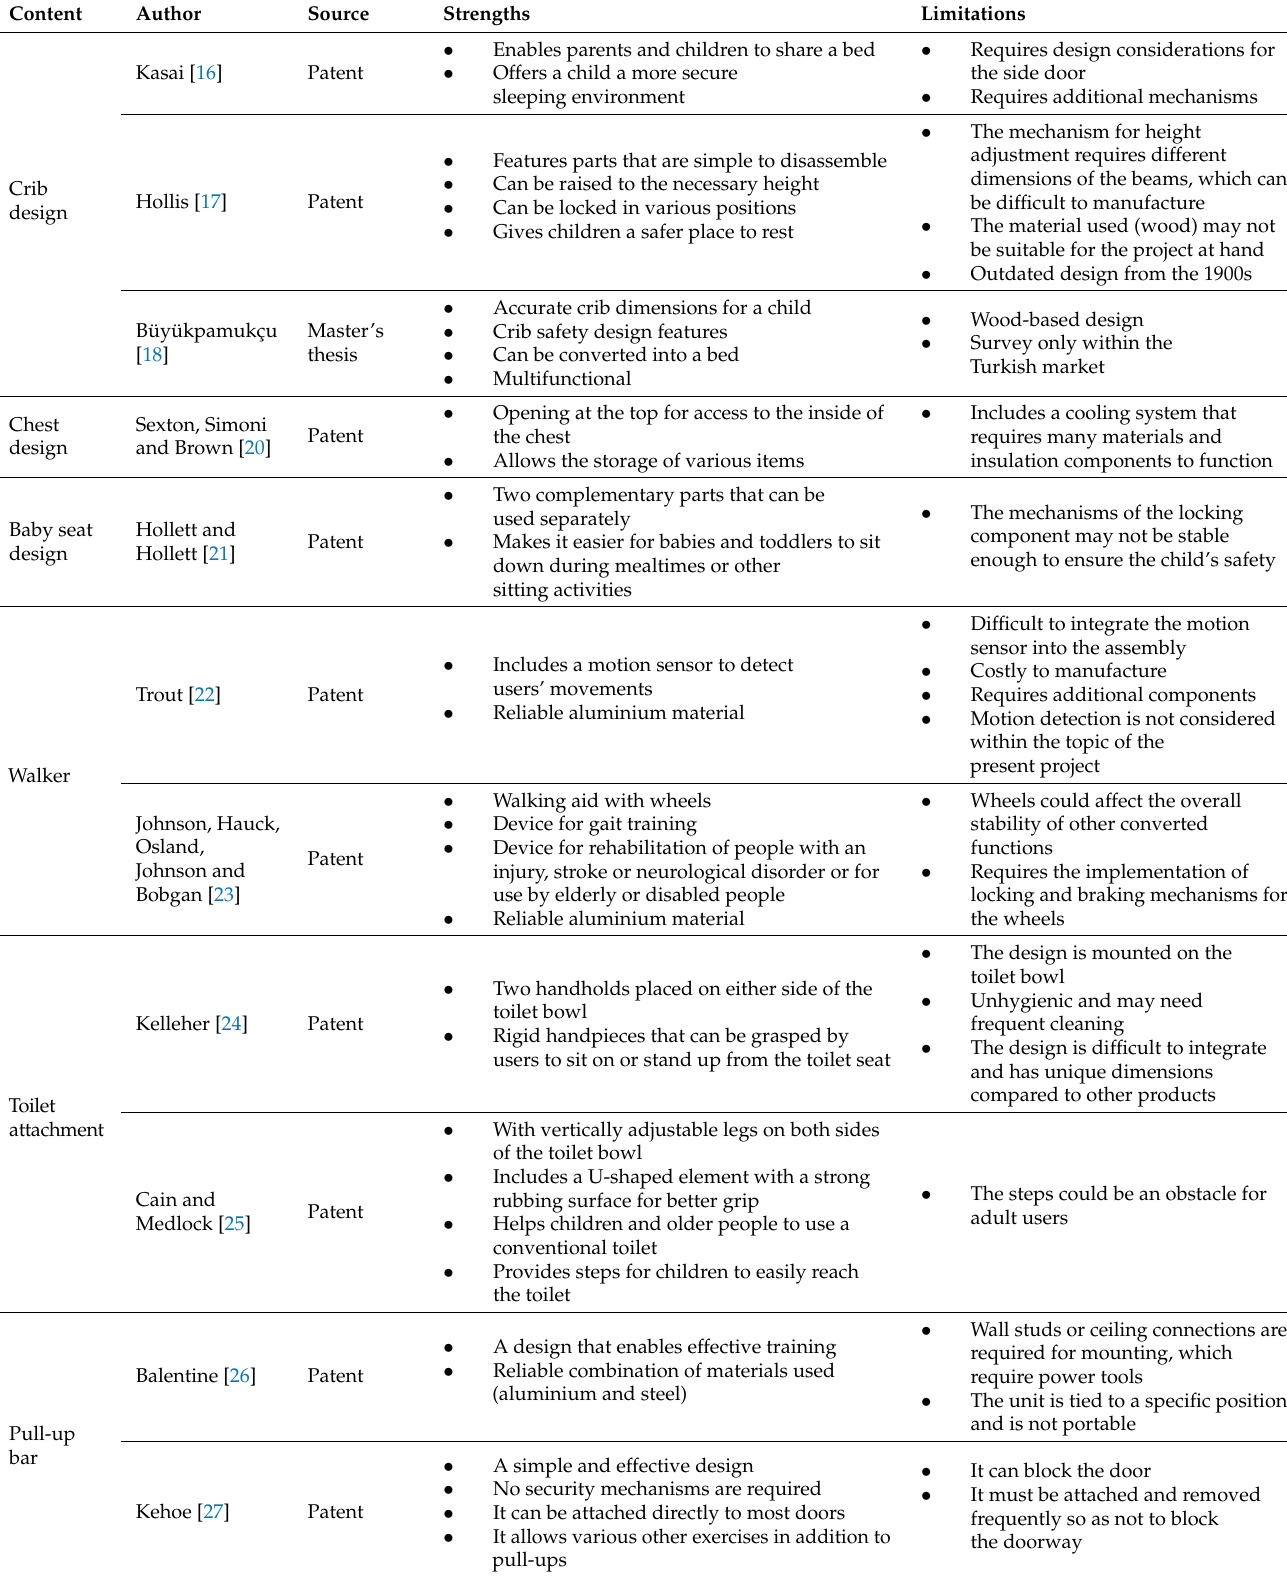
Table 1. Synthesis of key findings from past studies (strengths and